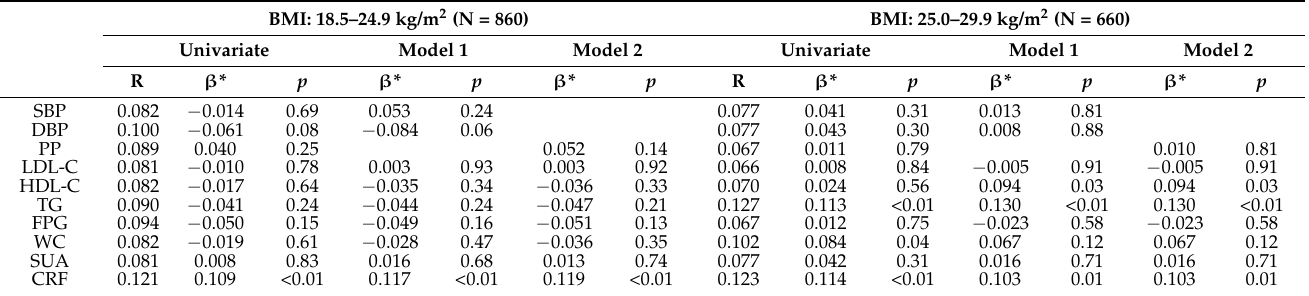
Table 4. Correlations of physical performance and cardiometabolic risk factors with carotid intima– media thickness between the overweight and the normal